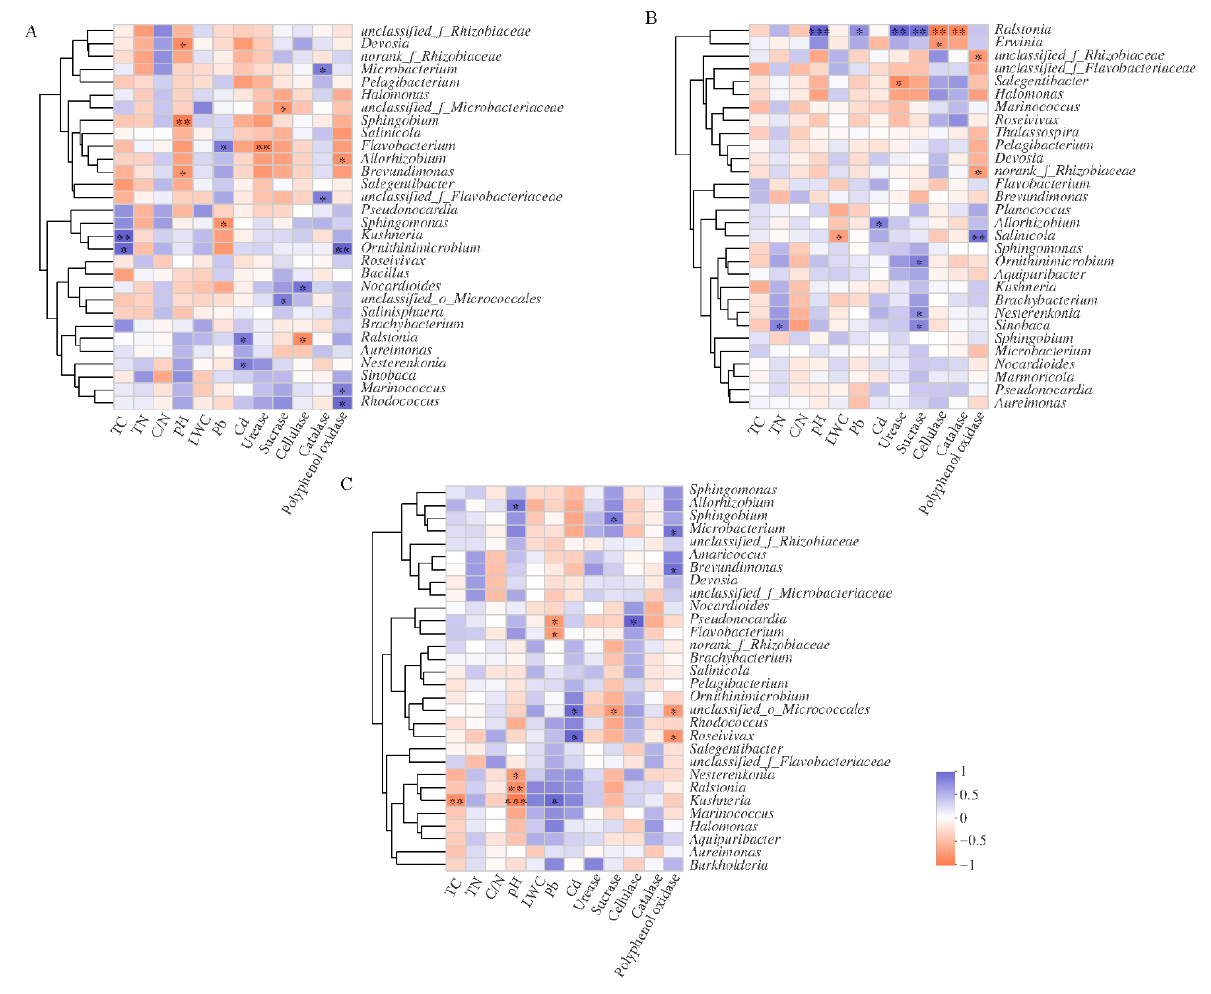
Figure 4. Correlation analysis of litter properties and dominant bacterial genera treated with RI ( A ), GM ( B ), and NM ( C ). Significance levels were denoted with * p < 0.05, ** p < 0.01 and *** p < 0.001.